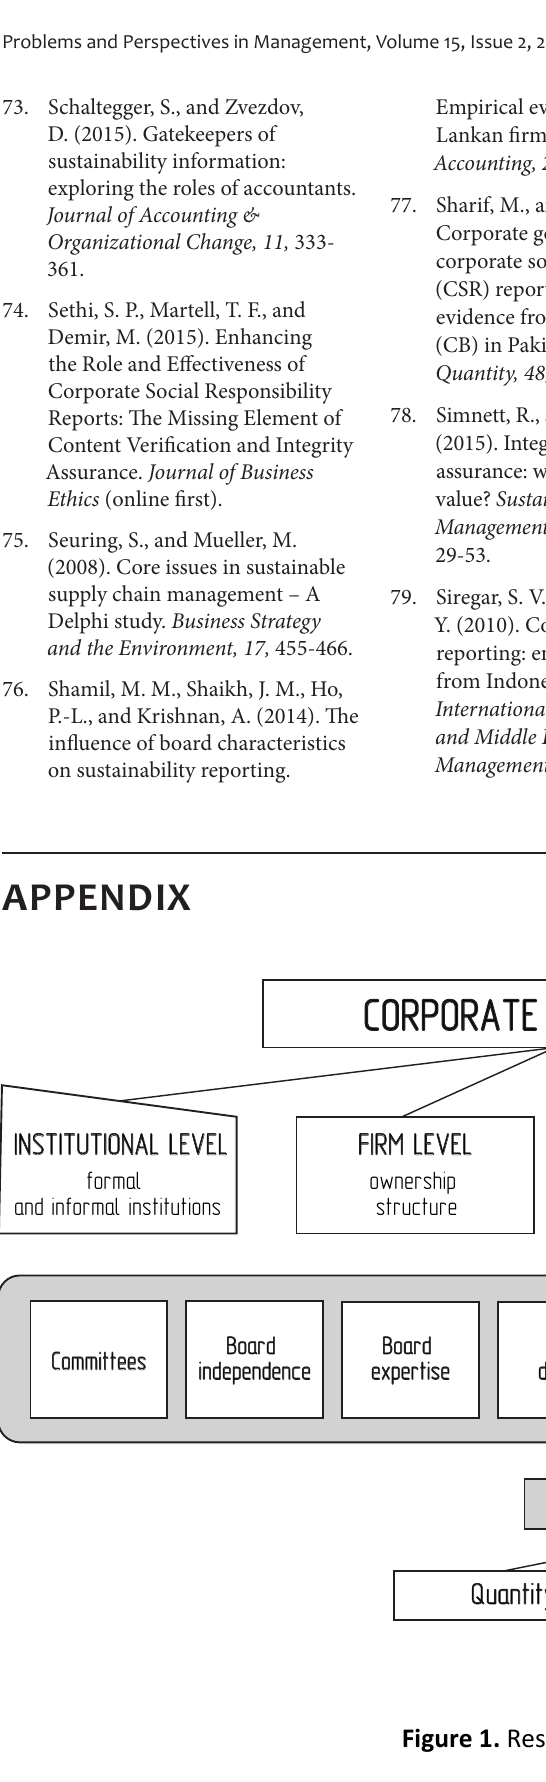
Figure 1. Research